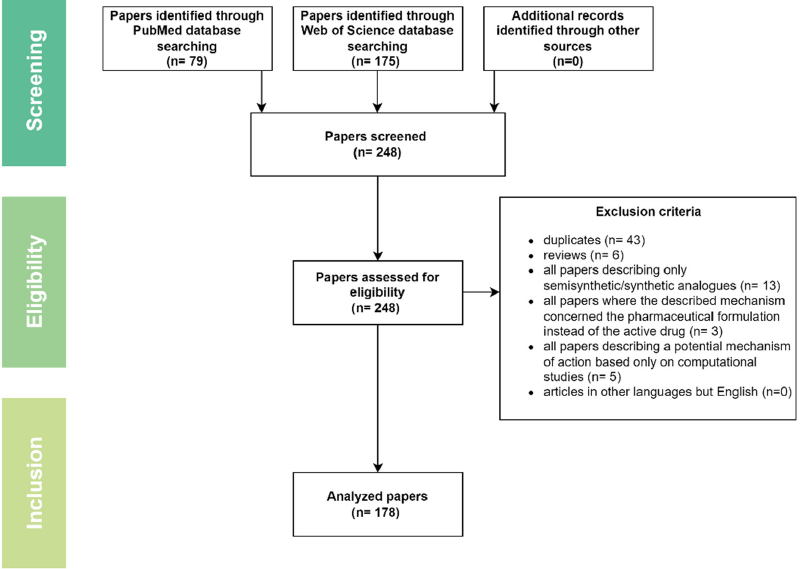
Figure 1. Flow diagram describing the data selection process.